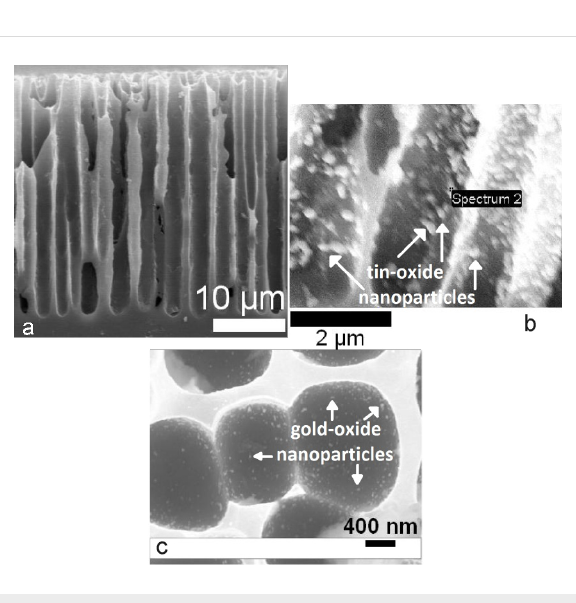
Figure 11: (a) Close up side view of hybrid porous silicon film. (b) 10–100 nm SnO x nanoparticle tin-oxide deposits on porous silicon micropores; (c) 10 to 30 nm Au x O nanostructures on porous silicon. Reproduced with permission from [3]. Copyright 2010